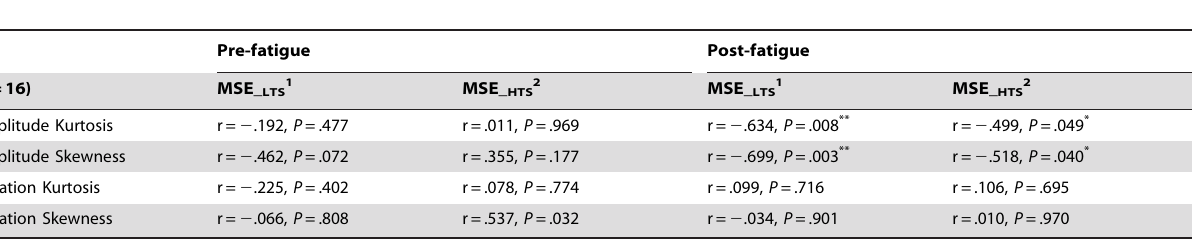
Table 4. Pearson’s correlation coefficients between the complexity of force fluctuations and statistical properties of force pulse.